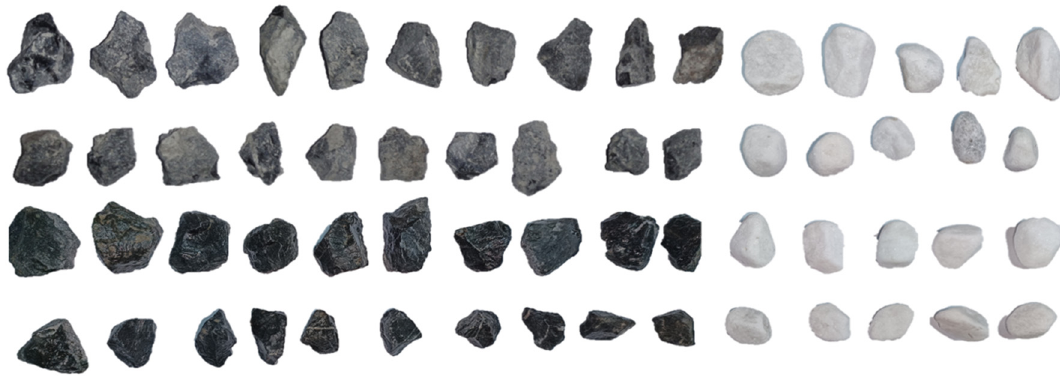
Figure 9. Coarse aggregates used in the experiment.